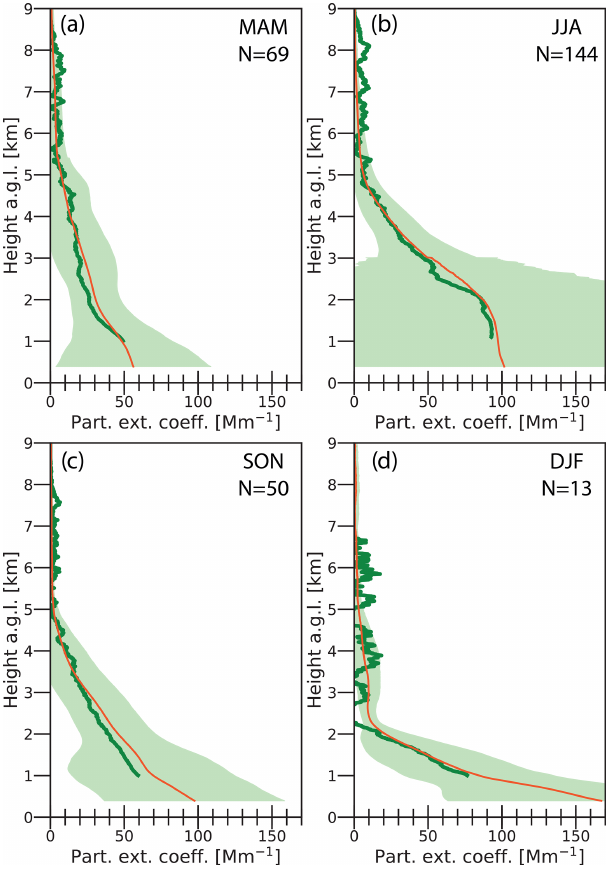
Figure 10. Seasonal mean 532nm total (dust + non-dust) particle extinction coefficient for (a) spring, (b) summer, (c) autumn, and (d) winter. The thick dark green line shows the mean extinction coefficient directly computed from the nitrogen Raman signal pro- files. The red line is obtained from the same lidar nighttime obser- vations but in terms of the respective 532nm backscatter coefficient profiles multiplied by a lidar ratio of 35sr (in a – c , spring, summer, autumn) and 50sr (in d , winter). The green shadow shows the atmo- spheric variability (one standard deviation) based on the backscat- ter coefficient profiles per season. The N values show the number of available Raman lidar observations per season. The maximum near-surface aerosol extinction coefficient was about 1500Mm − 1 occurring in the summer season during severe dust